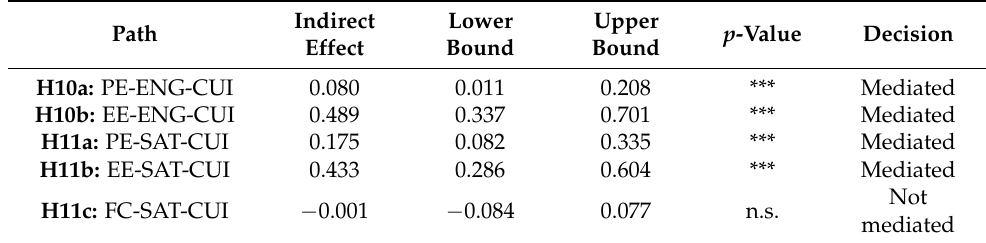
Table 7. Bootstrapping